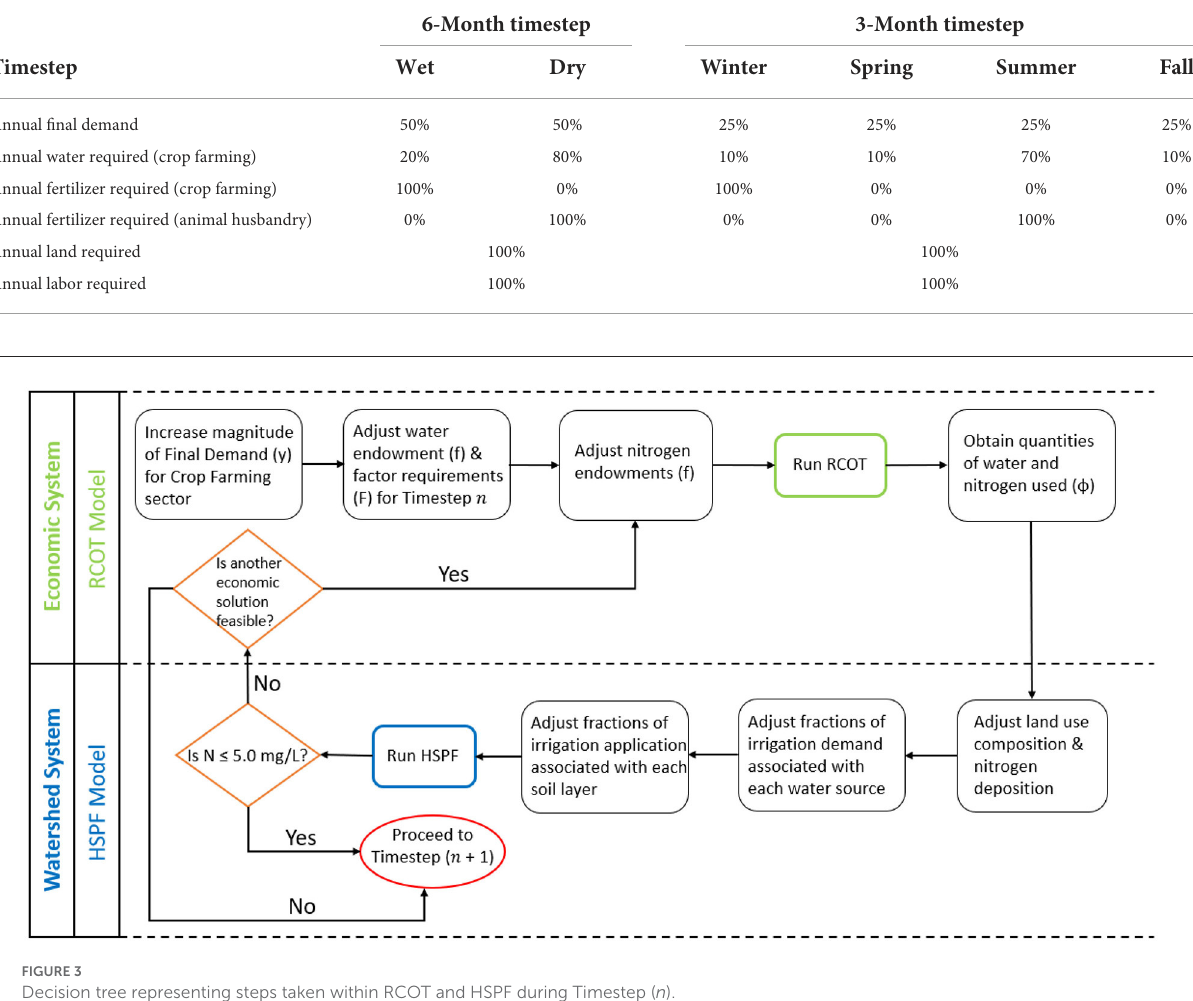
TABLE 1 Percent of annual final demand and factor requirements utilized in each season.